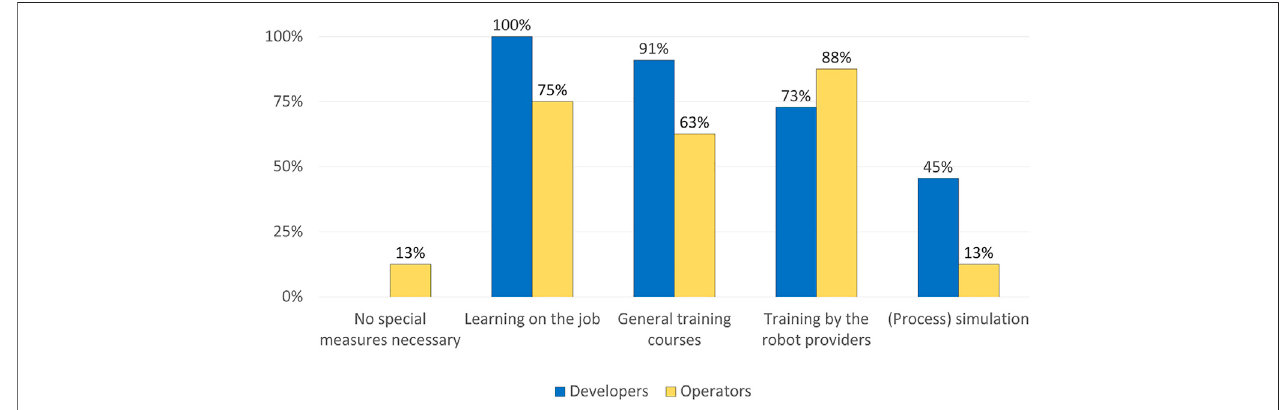
FIGURE 5 | Mix of training measures are required (ROBOHARSH, own